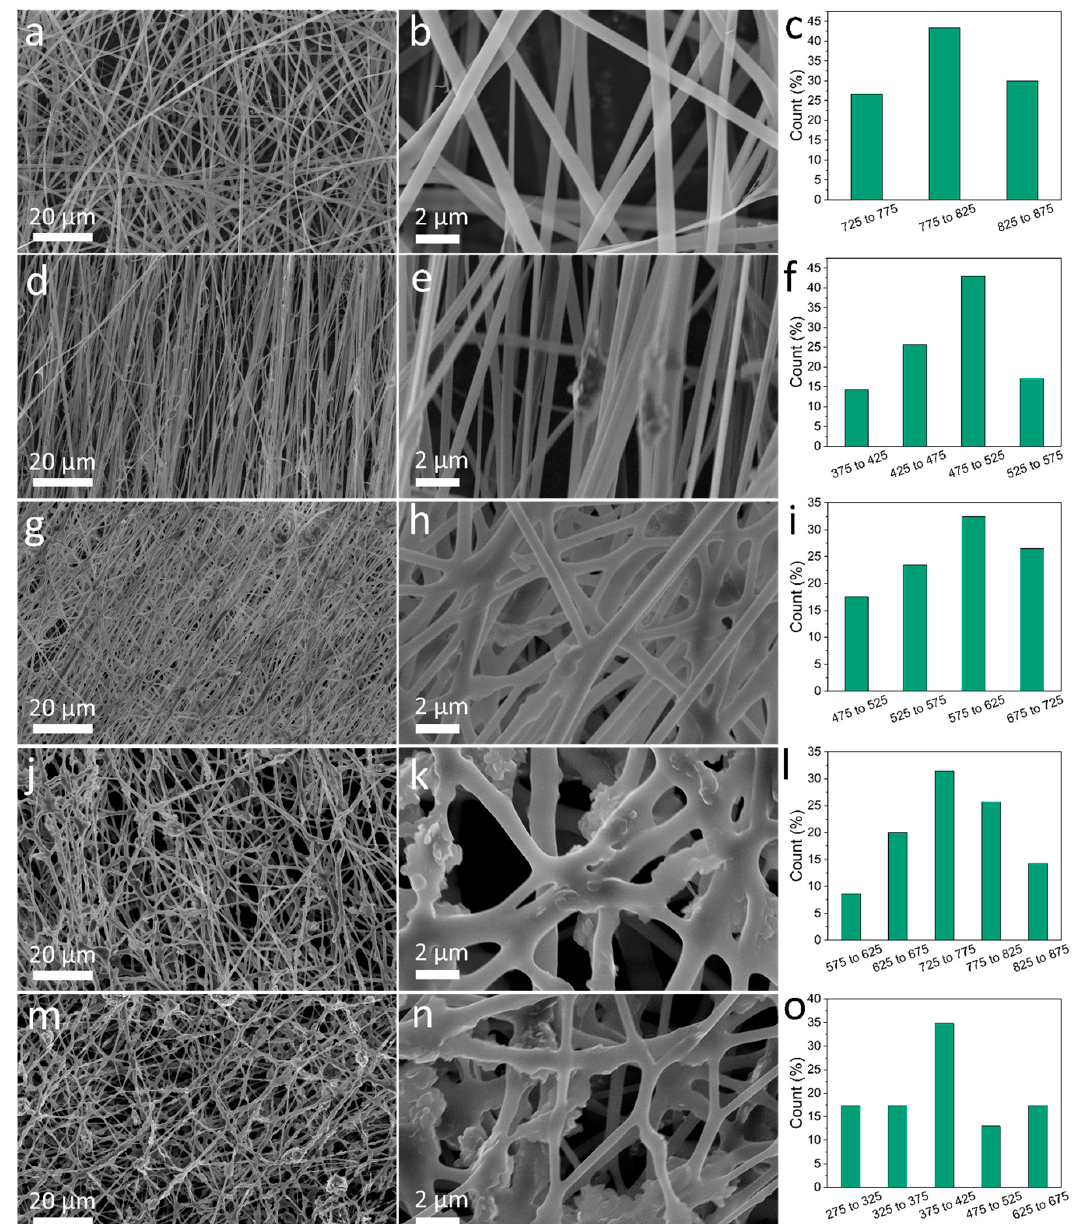
Figure 1. Scanning electron microscopy (SEM) images of pure silk fibroin (SF) ( a , b ), 5% boron nitride silk fibroin (BNSF) ( d , e ), 10% BNSF ( g , h ), 30% BNSF ( j , k ), and 40% BNSF ( m , n ) nanofibers; Quantitative analysis of diameter distribution of pure SF ( c ), 5% BNSF ( f ), 10% BNSF ( i ), 30% BNSF